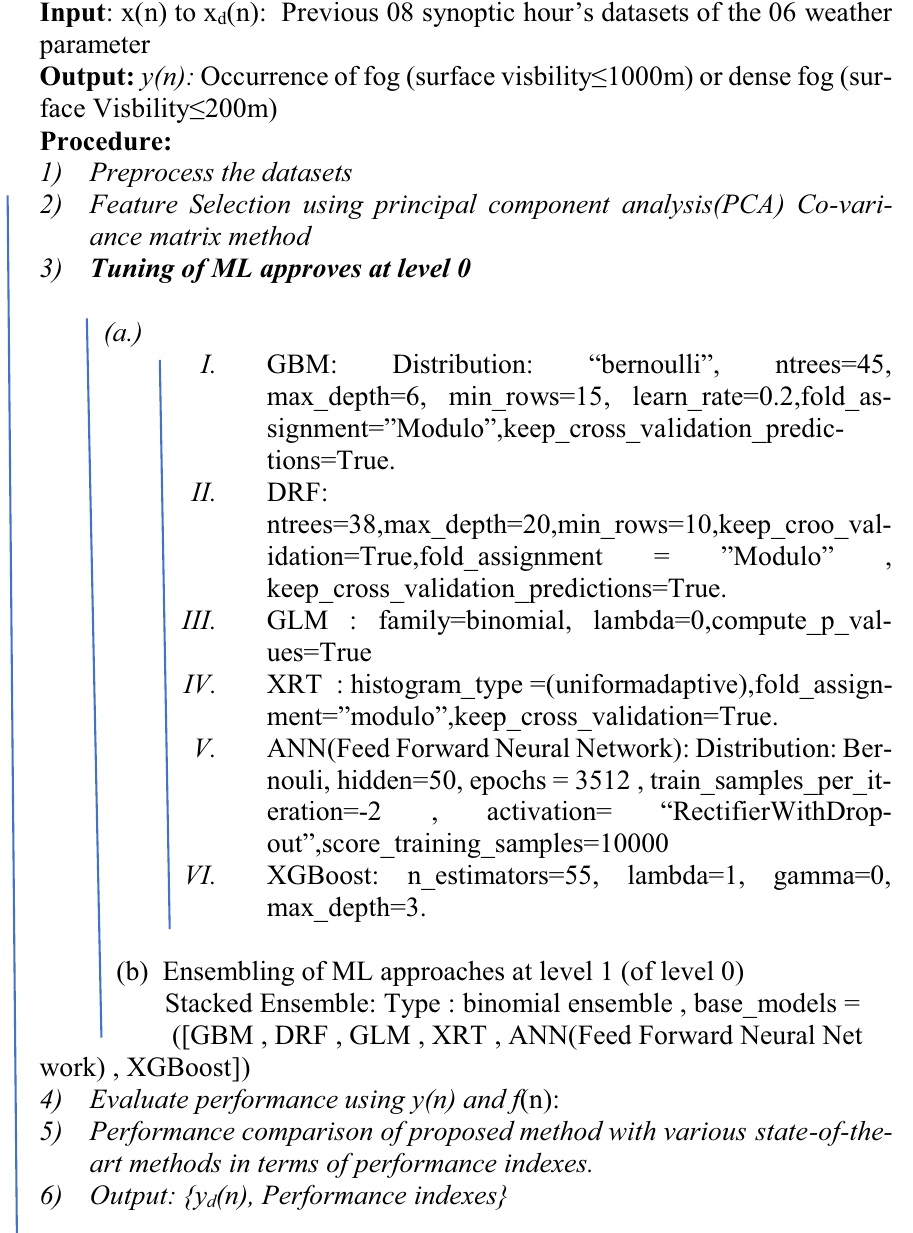
Algorithm-1: Proposed stacked ensemble approaches for the prediction of fog(surface visibility ≤ 1000m) and dense fog(surface visbility≤200m) for the lead time of 06 hours to 01 hours